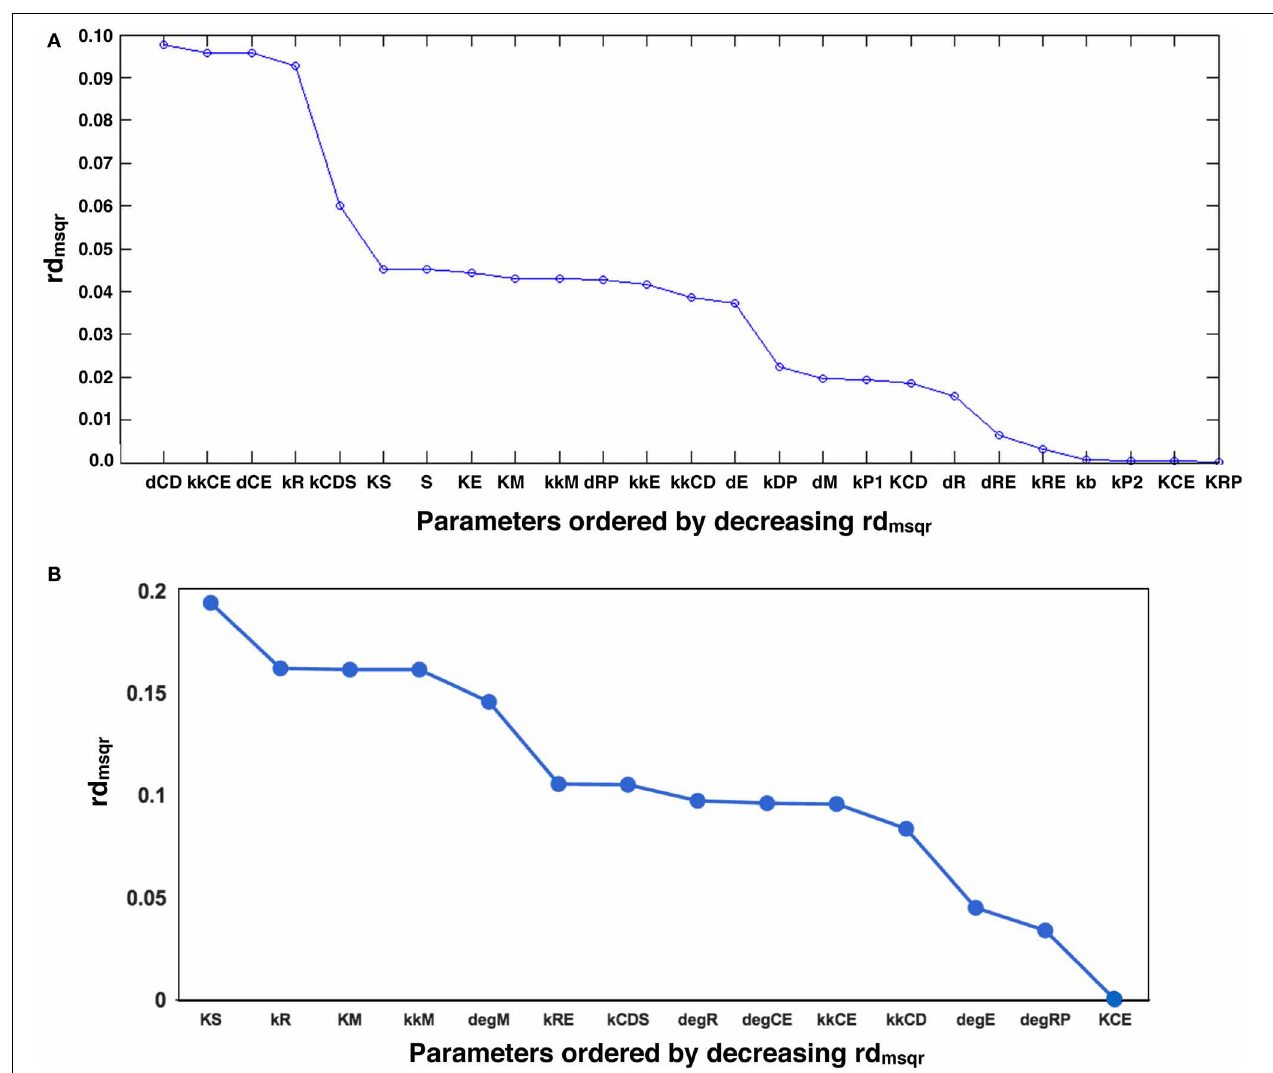
FIGURE 10 | LSA and GSA results of the third optimization of parameters. (A) The results of LSA. There was no parameter that was more sensitive than the original. (B) The results of GSA. KS, kkM, and kRE were larger than the original parameter cases; and KS, KM, kkM, kRE, kCDS, kkCD,